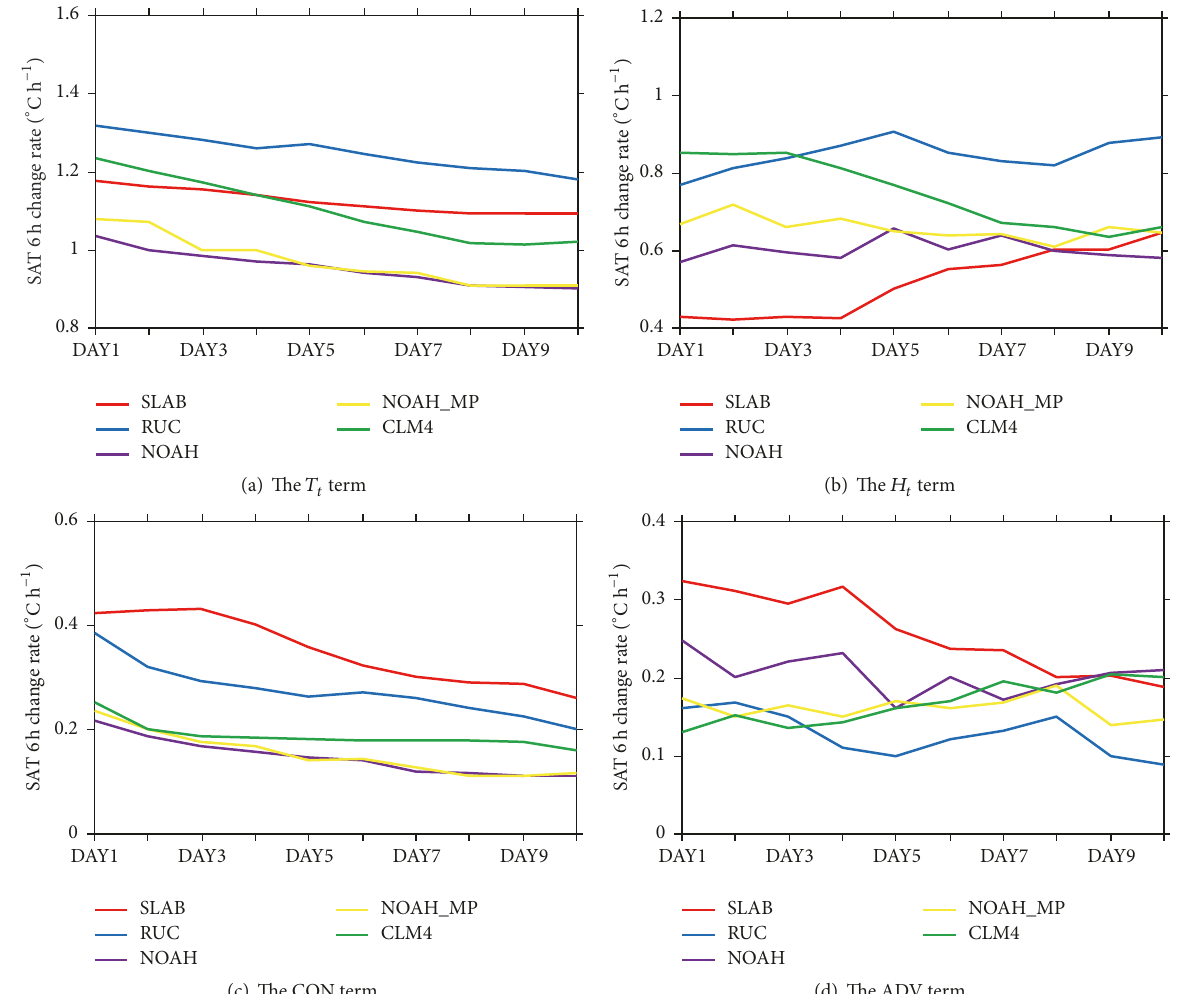
Figure 9: Domain A3-averaged change rates of SAT (unit: ∘ Ch −1 ) for the 𝑇 𝑡 (a), 𝐻 𝑡 (b), CON (c), and ADV (d) terms.